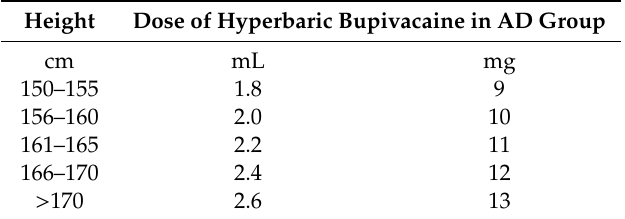
Table 1. Height-adjusted bupivacaine doses used in adjusted-dose (AD) group. Height Dose of Hyperbaric Bupivacaine in AD Group cm mL mg 150–155 1.8